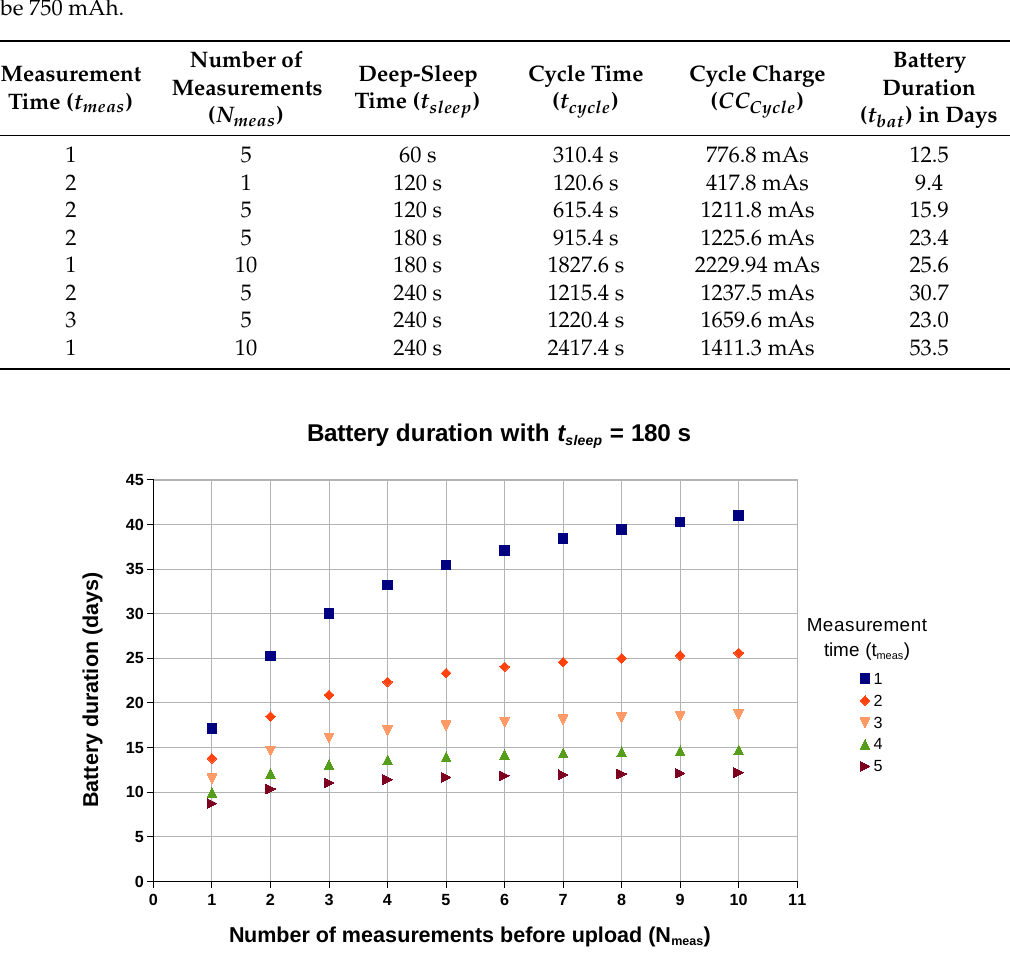
Table 5. Estimated battery life for several cases of interest. The capacity of the battery is considered to be 750 mAh.